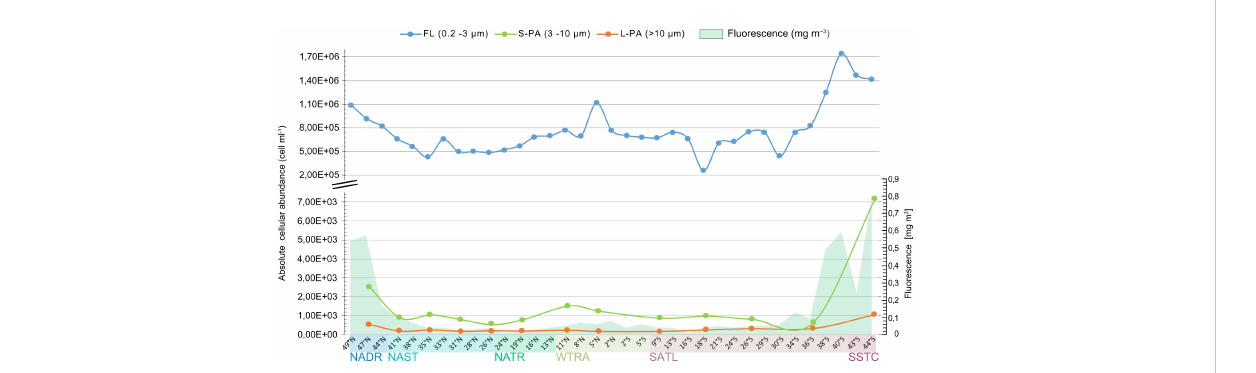
FIGURE 3 Total bacterial cellular abundance determined by CARD-FISH using the EUB I-III general bacteria probes of the free-living (FL, blue),small particle(S- PA, green),and large particle (L-PA, orange) fraction across the Atlantic Ocean sampled during the AMT22 cruise in 2012. Fluorescence is shown in